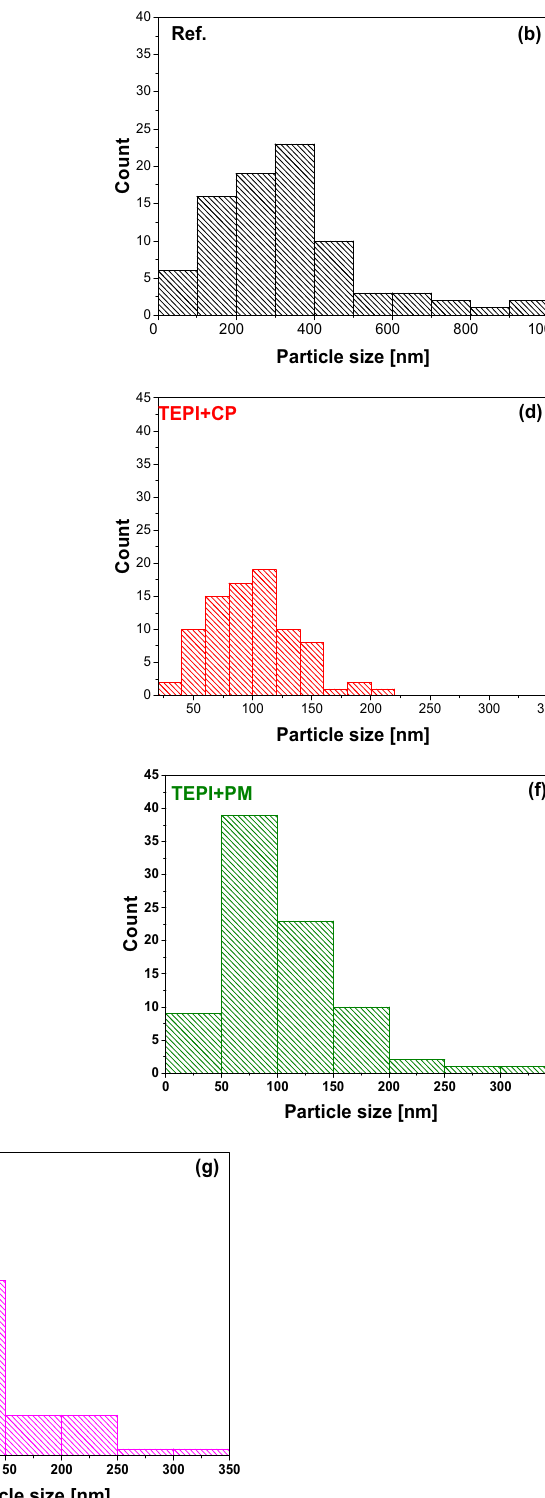
Figure 11: Histograms of the cluster size distribution for the reference silica and the modi fi ed silicas in the polymer matrix. ( a ) and ( b ) Represent the reference silica cluster size distribution. ( c ) Represents the TEPI + E modi fi ed silica cluster size distribution. ( d ) Represents the TEPI + CP modi fi ed silica cluster size distribution. ( e ) Represents the TEPI + TB modi fi ed silica cluster size distribution. ( f ) Represents the TEPI + PM modi fi ed silica cluster size distribution. ( g ) Represents the TEPI + NM1 modi fi ed silica cluster size